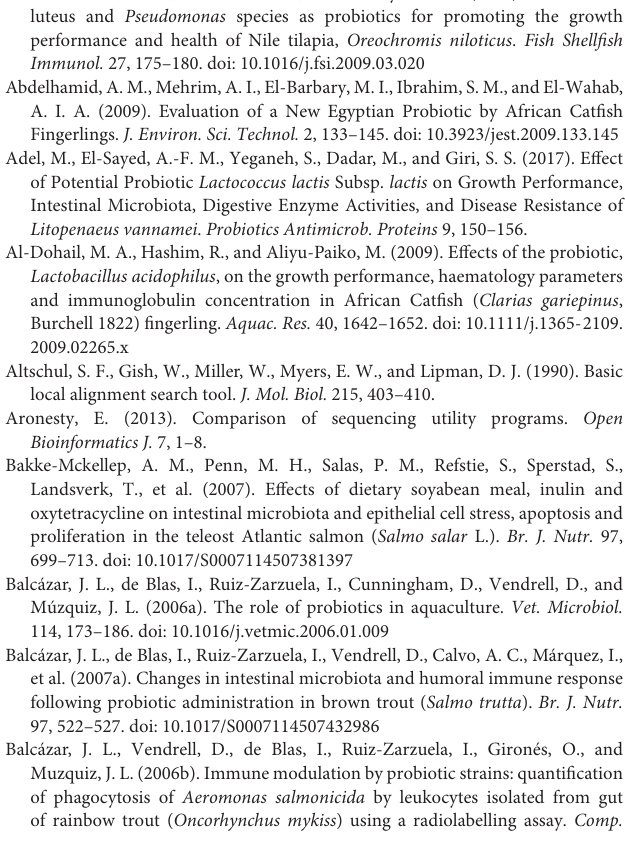
control and experimental diets.